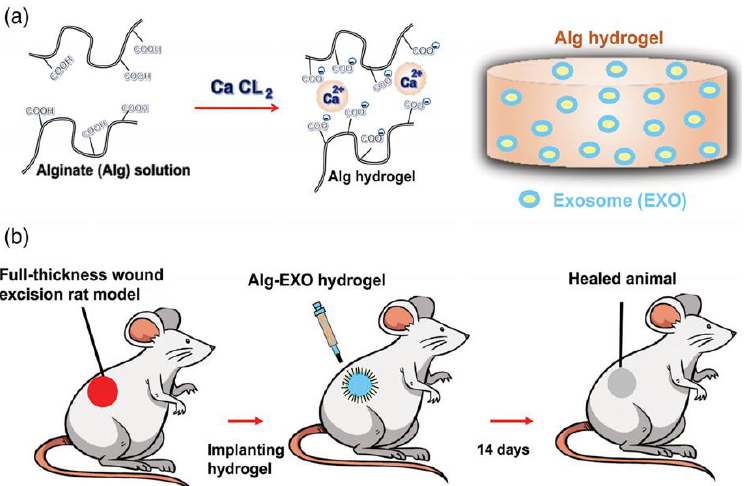
Figure 4. Schematic illustration of the hydrogel crosslinking and full-thickness wound excision mouse model used to evaluate the wound healing properties of alginate hydrogel-incorporated exosome (Alg-EXO). ( a ) Alginate solution loaded with adipose-derived stem cells (ADSCs)-derived EXOs cross-linked via ionic crosslinking. ( b ) Creation of a full-thickness wound excision rat model, and the transplantation of hydrogel into the injury area. Image reproduced with permission from Shafei et al. [98]. Copyright 2019, John Wiley and Sons.